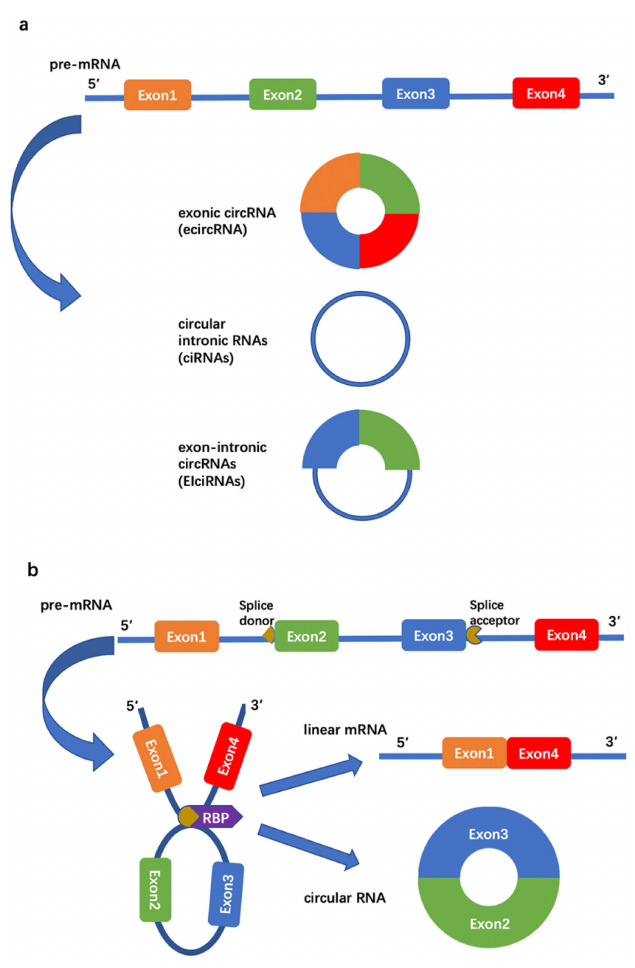
Figure 1. Formation of circRNAs. ( a ) Three types of circRNAs according to their sources of pre- mRNA. ( b ) RNA-binding protein (RBP) induces circulation. Circular exons are generated by pre- mRNA through back-splicing between the splice donor site of a downstream exon (the 5 (cid:48) end of exon 2) and the splice acceptor site of an upstream exon (the 3 (cid:48) end of exon 3). This event can be mediated by RBPs or specific sequence elements, resulting in the production of a circular RNA and a linear RNA. Blue lines represent